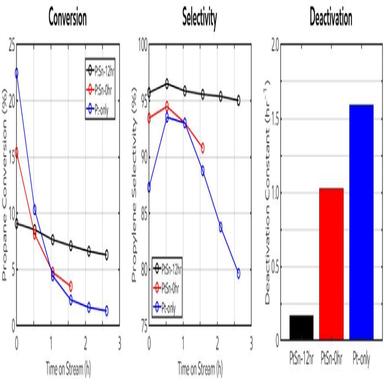
Catalytic results of PtSn-12hr (black), PtSn-0hr (red), and Pt-only (blue) sample in fixed-bed reactor for propane dehydrogenation. Reaction conditions: 5 mg catalyst, 20 mL/min propane and 60 mL/min N2 as feed gas, 600 C. The deactivation constants are obtained through the following formula: ln = kd T + ln, where Xfinal and Xinitial are the final and initial propane conversions, respectively, T is the lifetime of the catalyst measured in the catalytic test (1.5 h) and kd is the deactivation constant. The p